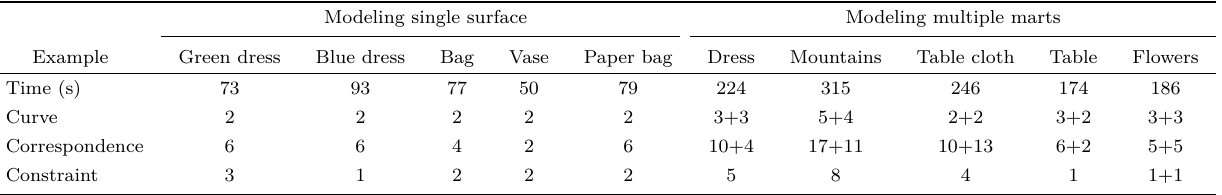
Fig. 7 Modeling results using our method. Top: input images. Middle: cross sections sketched by the user and points in correspondence. Bottom: reconstructed 3D models. Table 1 Modeling time and numbers of input curves, correspondences, and constraints for each